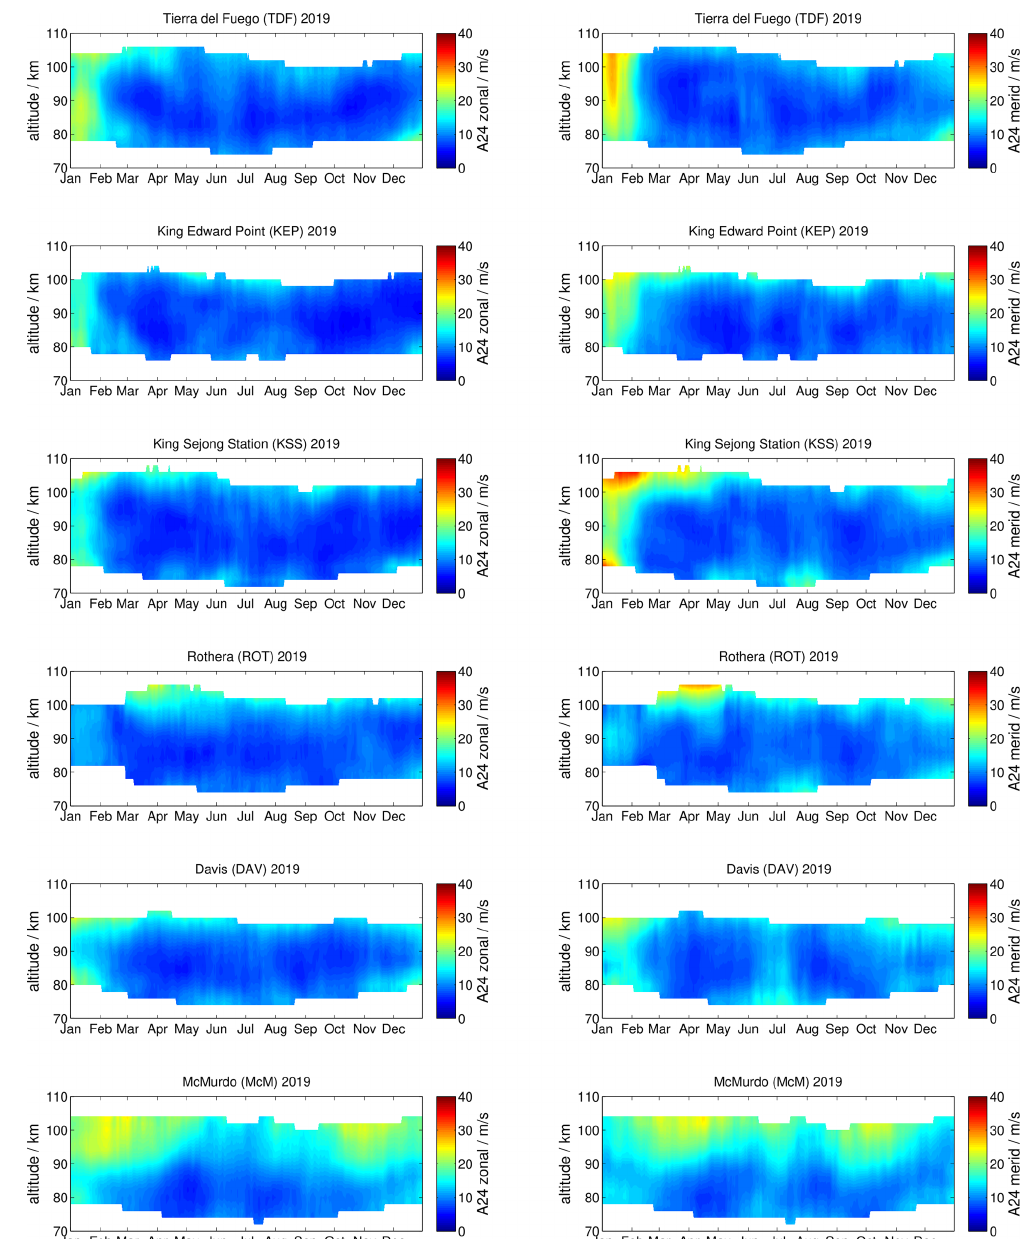
Figure 3. Same as Fig. 2 but for the diurnal tidal